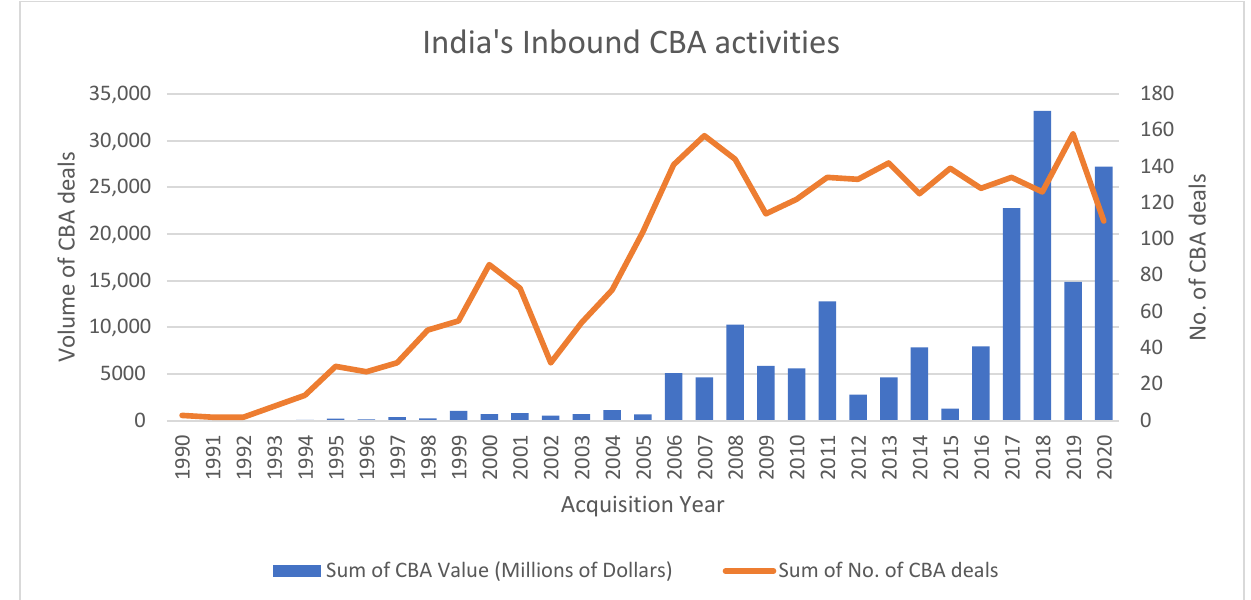
Figure 1. India’s inbound CBA value (in USD millions) from 1990 to 2020. (Source: Authors’ presen- tation of data sourced from UNCTAD World Investment Report. https://unctad.org/topic/invest- ment/world-investment-report?tab=Annex%20Table, accessed on 5 May 2022).